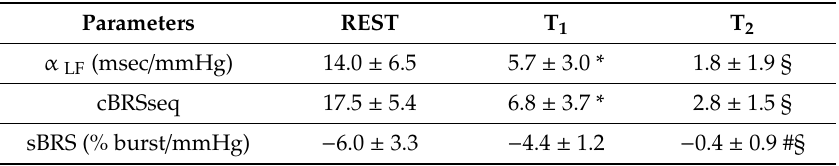
Table 2. Arterial Baroreflex control of heart rate ( α index and cBRSseq) and baroreceptor modulation of MSNA (sBRS) while supine (REST), during the asymptomatic phase of tilt (T 1 ) and the period of tilt just preceding syncope (T 2 ). Values are expressed as mean ± standard deviation.